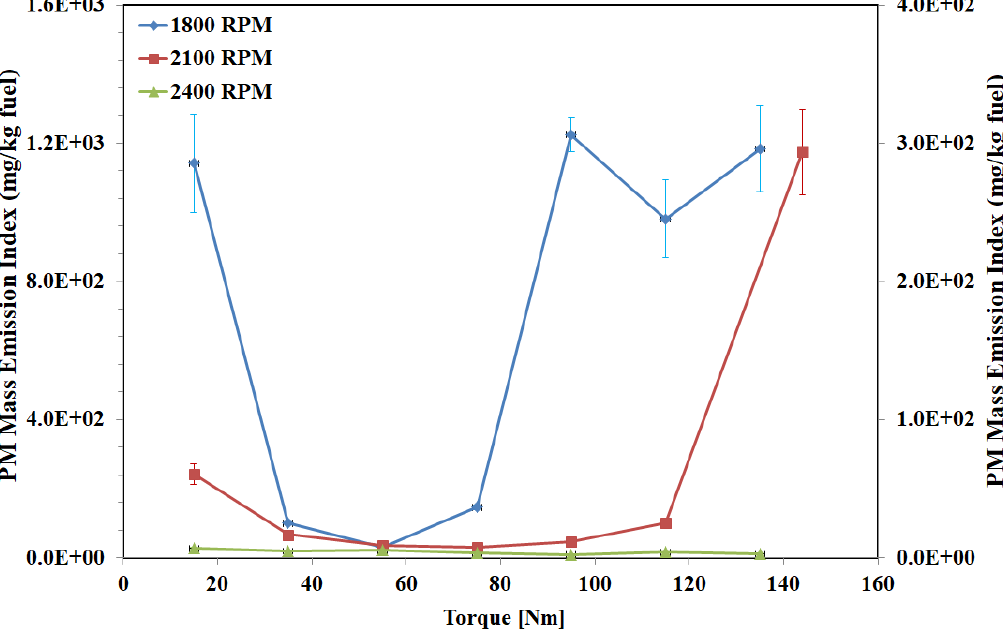
Figure 2. PM mass emission index (EI M ) versus torque. Error bars represent one standard deviation.